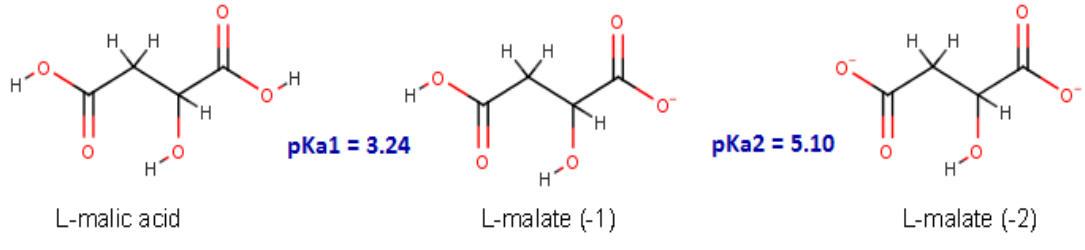
Figure 2. Chemical structure of L -malic acid and its protonation states. Table1. Bindingenergies( ∆ G)of l -malatewithmalolacticenzymeusingisothermaltitrationcalorimetry.